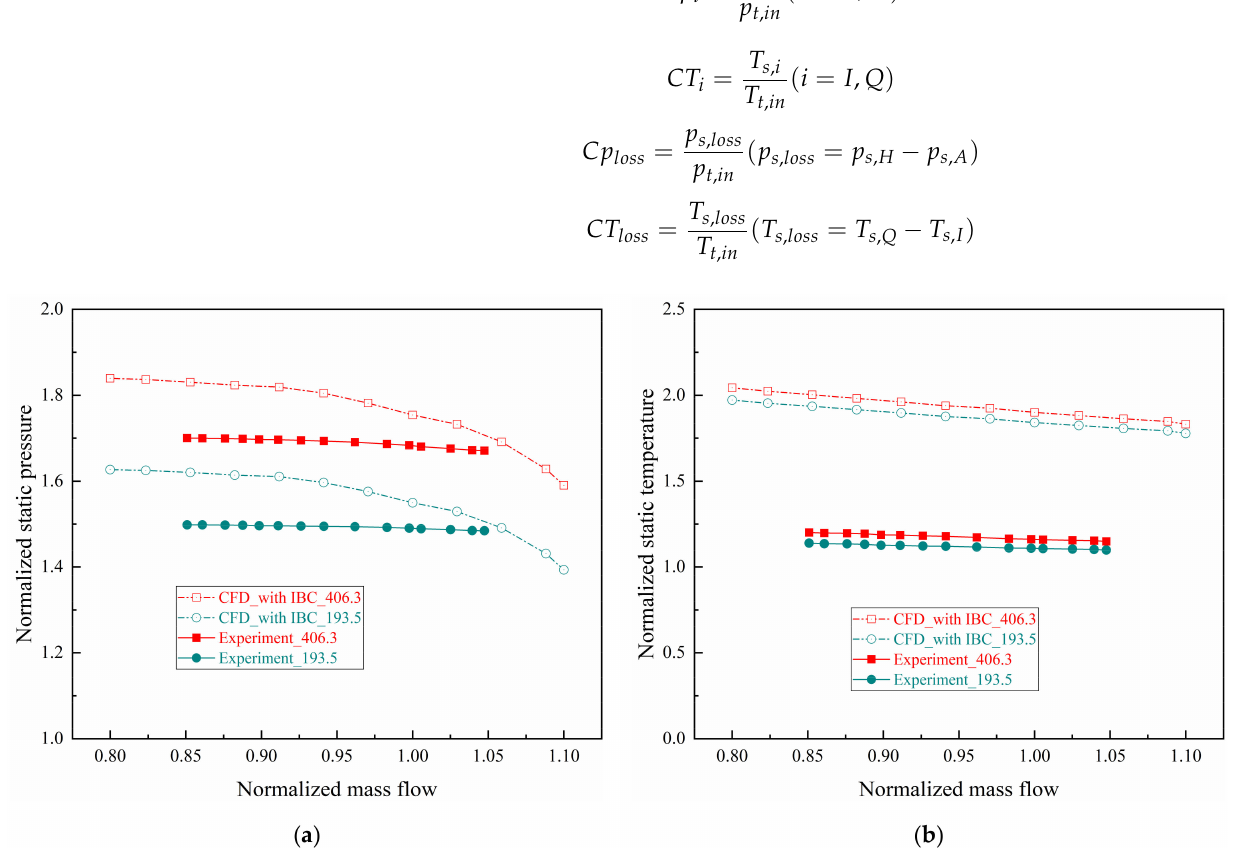
Figure 8. Predicted and measured static pressure and static temperature on the static wall of IBC under design rotating speed: ( a ) Static pressure; ( b ) Static